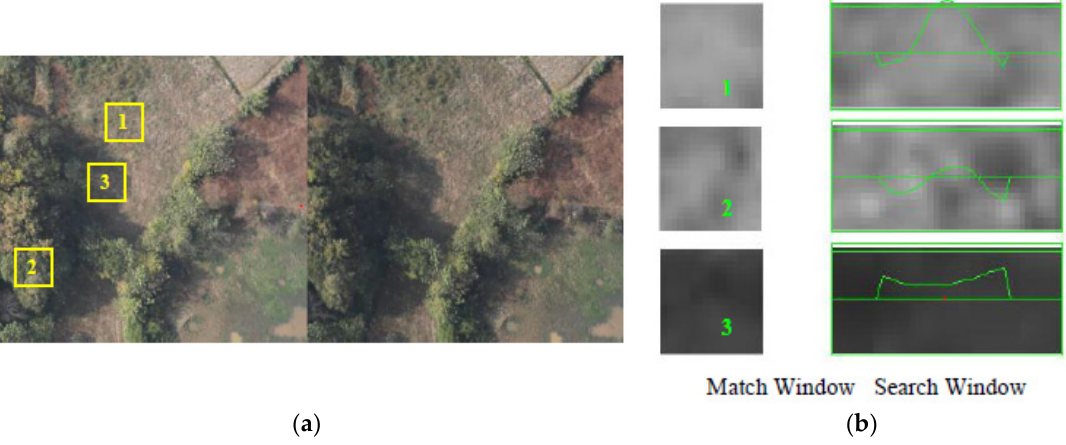
Figure 3. Similarity judgment considering the shape of CC curve. ( a ) Matching window ( b ) Correlation coefficient curve.